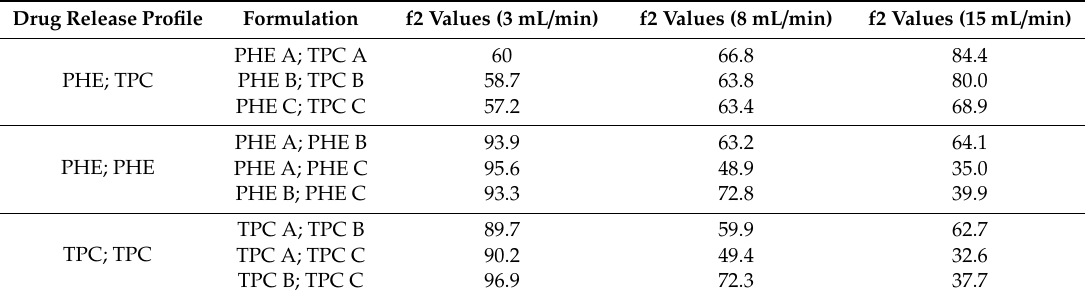
Table 3. Similarity factor f2 pairwise comparison of the drug release profiles at 3, 8, and 15 mL/min flow rates. Intra-formulations comparison of PHE and TPC release profiles, inter-formulations comparison of PHE release profiles and inter-formulations comparison of TPC release profiles.